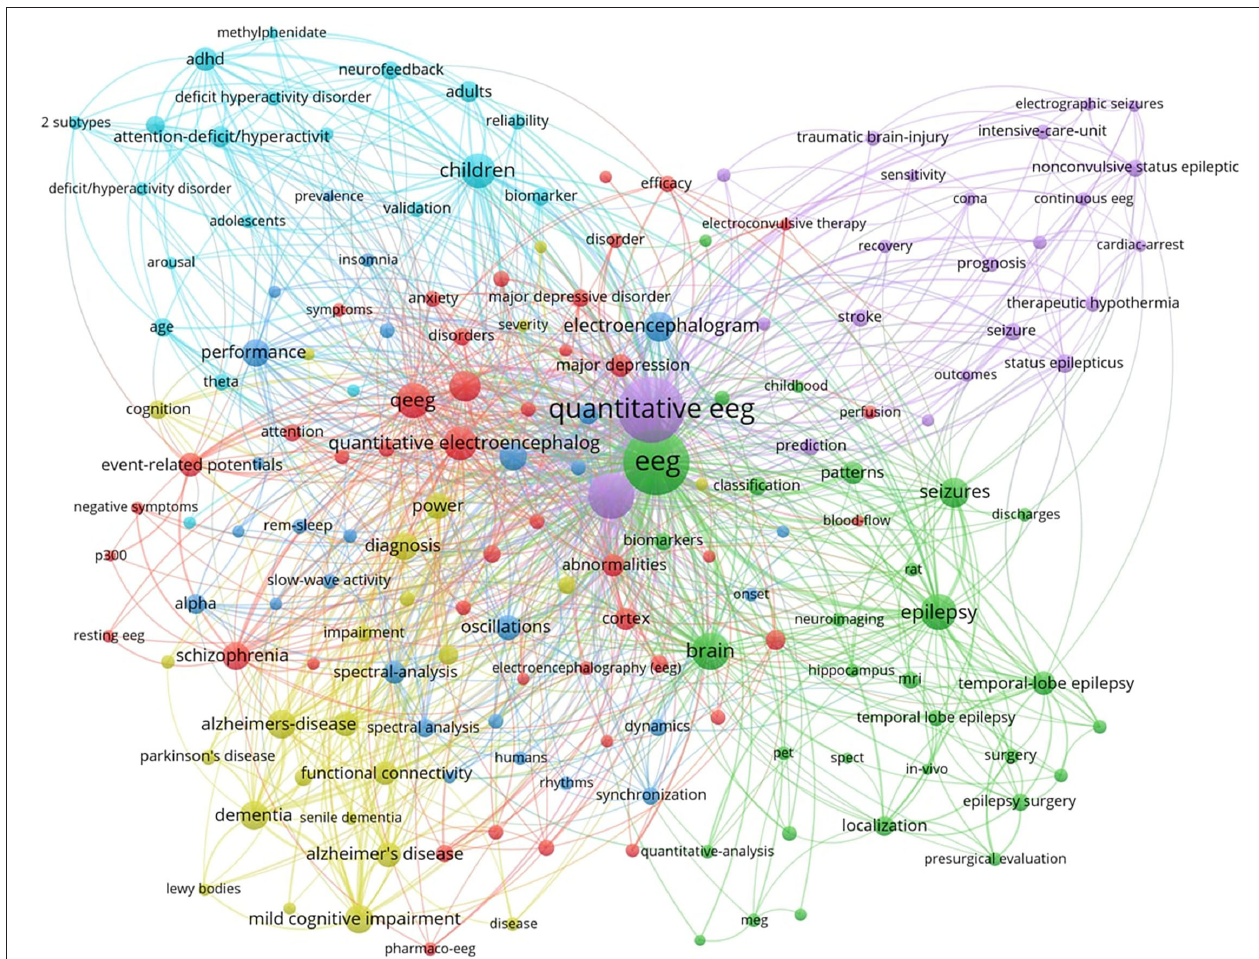
FIGURE 5 | The keyword co-occurrence